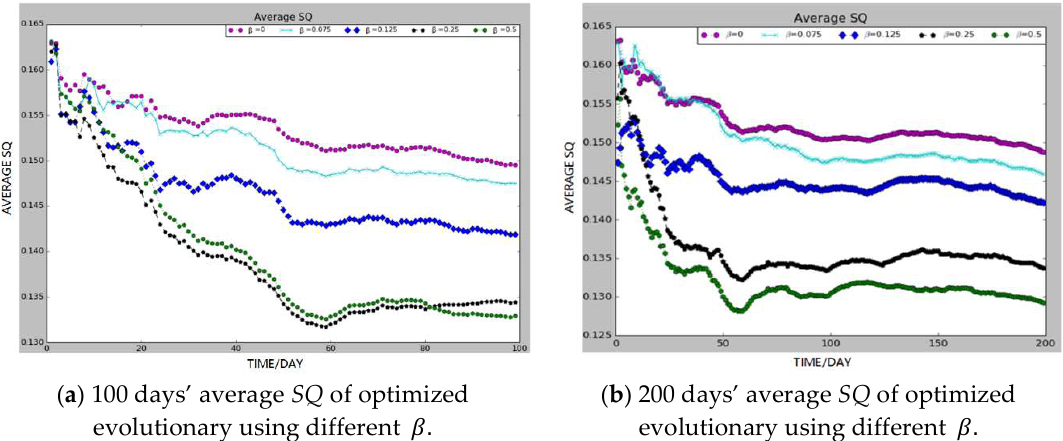
Figure 11. One hundred and 200 days’ average SQ of optimized evolutionary using di ff erent β in Shanghai dataset.